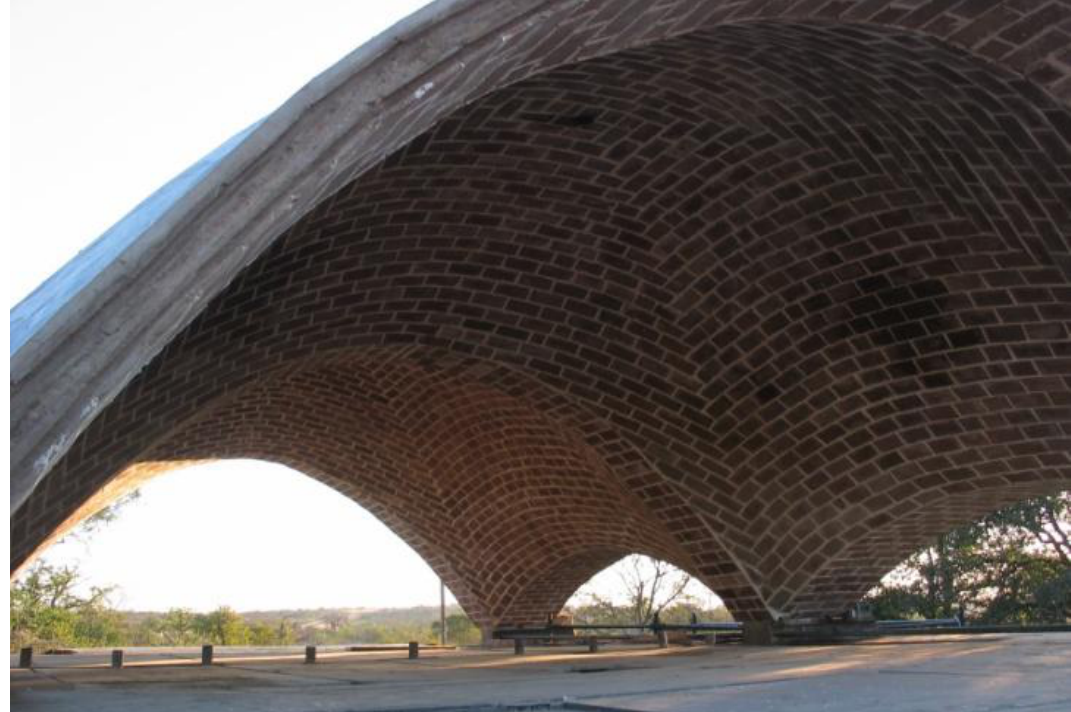
Figure 3 Showing part of the completed Mapungubwe Interpretation